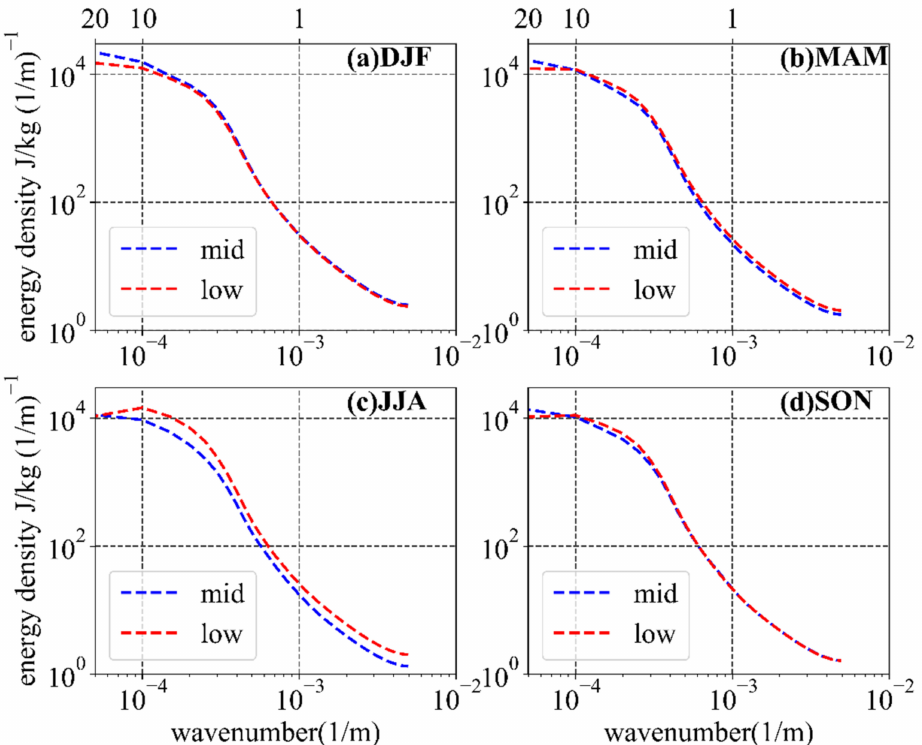
Figure 2. Vertical wavenumber spectra of the GW Ep. ( a – d ) Mean winter, spring, summer, and autumn spectra, respectively. The blue line represents the average for the middle latitude region, and the red line represents the average for the low latitude